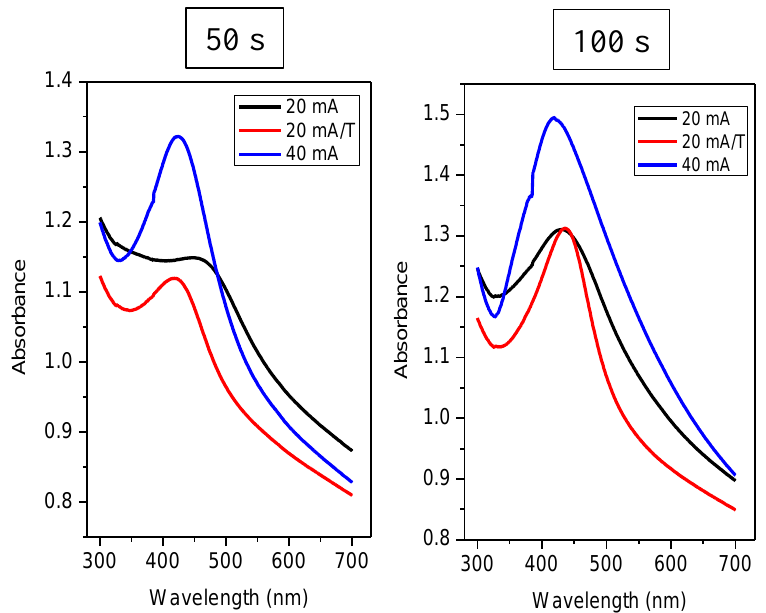
Figure 7. UV-VIS spectra of Ag layers on PDMS at different deposition times of 50 and 100 s, and currents of 20 and 40 mA or samples with the subsequent thermal treatment (20 mA/T).